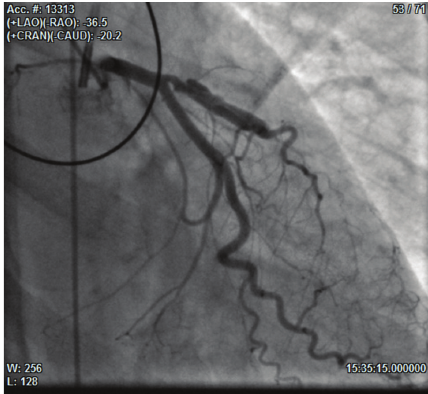
Figure 2: (36 ∘ RAO and 20 ∘ CAU): angiographic control at day 7 showing reopened dissection of the septalLAD and occlusion of diagonalLAD.